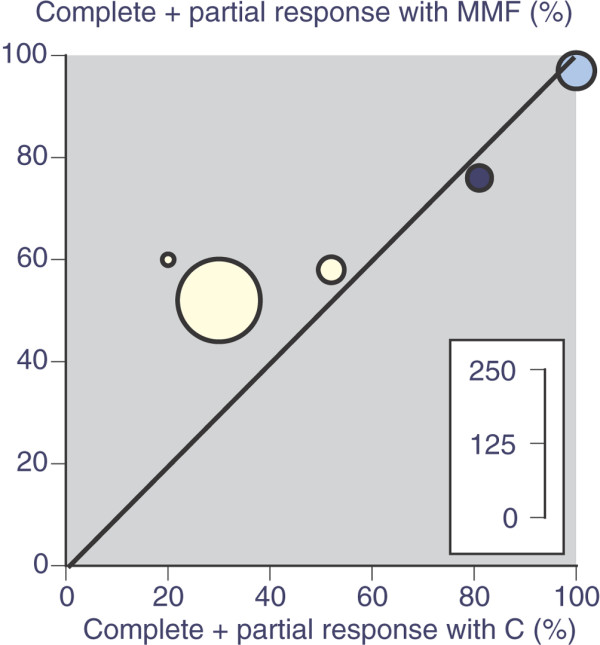
Complete plus partial response to oral mycophenolate mofetil (MMF) or intravenous or oral cyclophosphamide (C). The blue circles show trials with oral agents, with the sole maintenance trial using oral agents in dark blue. The inset scale represents the overall number of patients in each comparison.